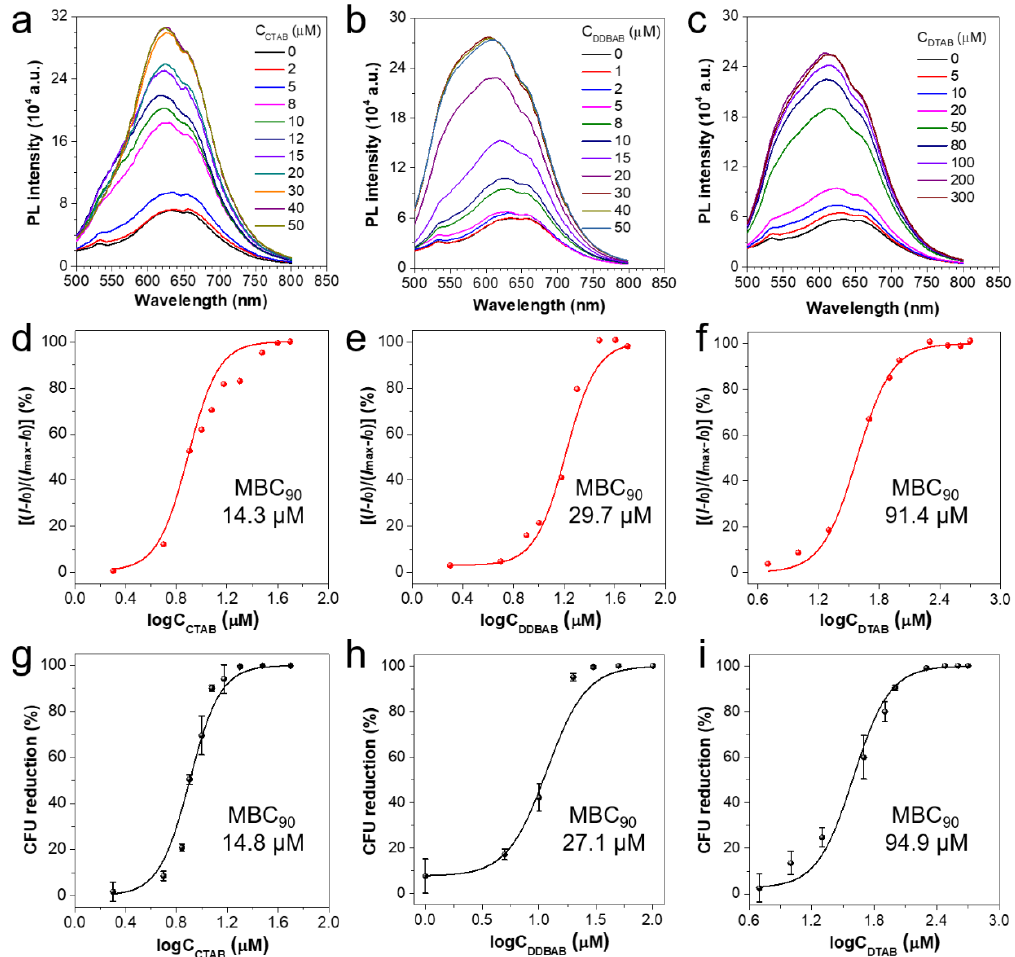
Figure 2. Evaluation of the activity of three antimicrobials. ( a – c ) Fluorescence spectra of E. coli suspension treated with different concentrations of antimicrobials and then stained with IQ-Cm (10 µ M): ( a ) CTAB, ( b ) DDBAB and ( c ) DTAB. ( d – f ) Plots of [( I − I 0 )/( I max − I 0 )] versus antimicrobial concentration, where I and I max correspond to the emission intensity and the achievable maximum intensity at 600 nm of the E. coli suspensions in the plots of a – c, respectively, and I 0 is the emission intensity of the E. coli suspension without the antimicrobial treatment; ( d ) CTAB, ( e ) DDBAB and ( f ) DTAB. ( g – i ) The plots of antibacterial activity of the three antimicrobials towards E. coli evaluated with the traditional agar plate culture method: ( g ) CTAB, ( h ) DDBAB and ( i ) DTAB. To monitor the membranolytic action of antimicrobials on Gram-negative bacterial OM and CM, the fluorescence images of E. coli treated with different concentrations of CTAB and then stained with IQ-Cm were taken under a fluorescence microscope. As shown in Figure 3a, the emission color and location sites of IQ-Cm in bacteria depend on the CTAB concentration. In the control group without CTAB, E. coli show a negligible emission because of the barrier of the intact OM. After the addition of CTAB, the staining rate of E. coli with green or orange emission increases with increasing the CTAB concen- tration, which is 50% for 6 µM, 80% for 8 µM, 99% for 12 µM and 100% for >15 µM of